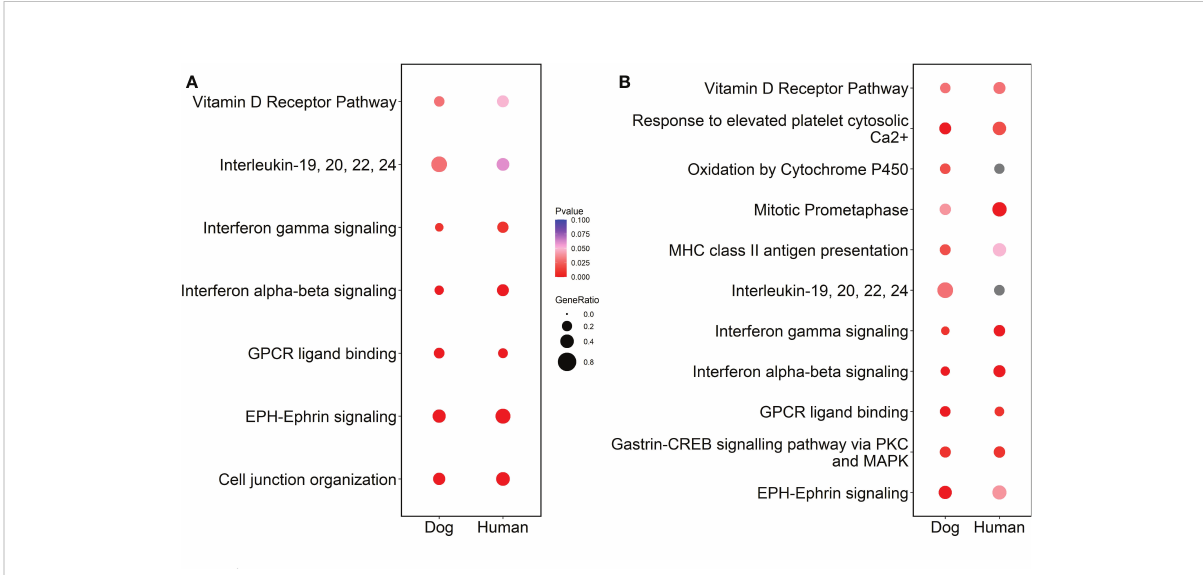
FIGURE 7 Cross-species comparison of RNA-seq data from the early tumors in dogs and human InvUC data from TCGA. Cross-species comparison was conducted using multi-omic pathway analyses in Strand and represented as dot plots using R. Pathway analyses were conducted concurrently using differentially expressed genes in the early canine tumors detected through screening (as compared to normal) and high grade human tumors stage T1-T3 (as compared to normal) in panel (A) or to human tumors stage T1-T2 in panel (B) . With the fi nding that the majority of the canine tumors had not yet penetrated beyond the muscle layer, the comparison to human T1-T2 tumors was of interest. Note, the WHO classi fi cation for canine bladder tumors differs somewhat from the classi fi cation for human bladder tumors (30, 57). In dogs, T2 tumors are invasive through the lamina propria and typically into the muscle layer of the bladder, and T3 tumors extend through the bladder serosa or invade adjacent organs. In humans, T1 tumors invade the lamina propria, T2 tumors extend into the muscle, T3 tumors invade the fat deep to the muscle and below the serosa, and T4 tumors extend through the serosa or invade adjacent organs. Signi fi cant pathways (p<0.05) were selected and compared across species in both analyses groups. Note the similarities in pathways between the canine and human tumors, along with expected differences in some. Interestingly, more relevant pathways were noted when the dog data was compared to human T1-T2 than when compared to human T1-3